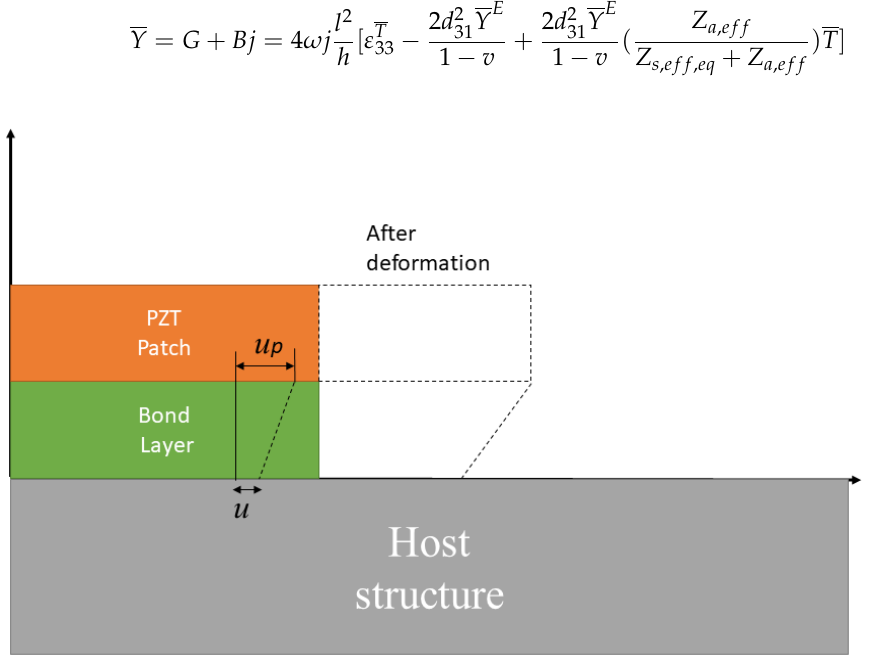
Figure 1. PZT Transducer deformation and bond layer.